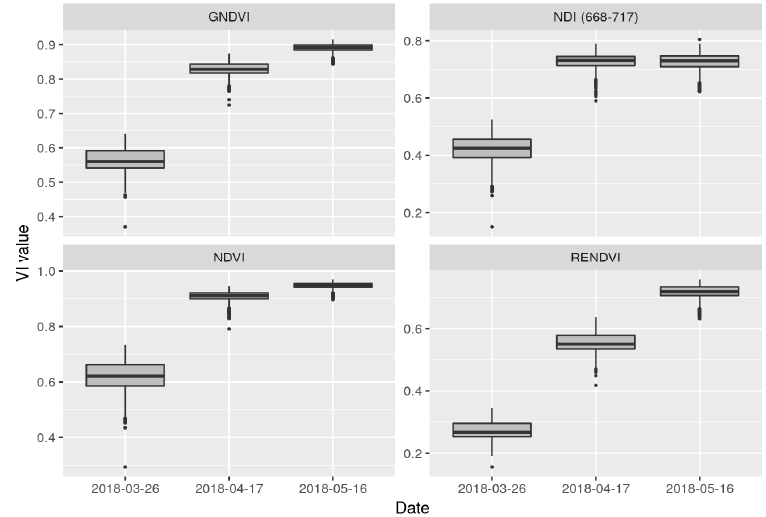
Figure 5. Temporal evolution of the VIs derived from spectral information acquired by MicaSense ® RedEdge-M TM sensor embedded on a quadcopter UAV on three dates in 2018 over the studied field sown with winter wheat. NDI (668-717) = NDI 668-717 .